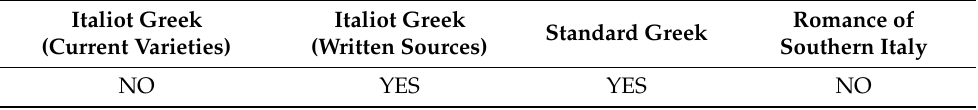
Table 4. Co-occurrence of demonstratives/adjectives and definite articles.